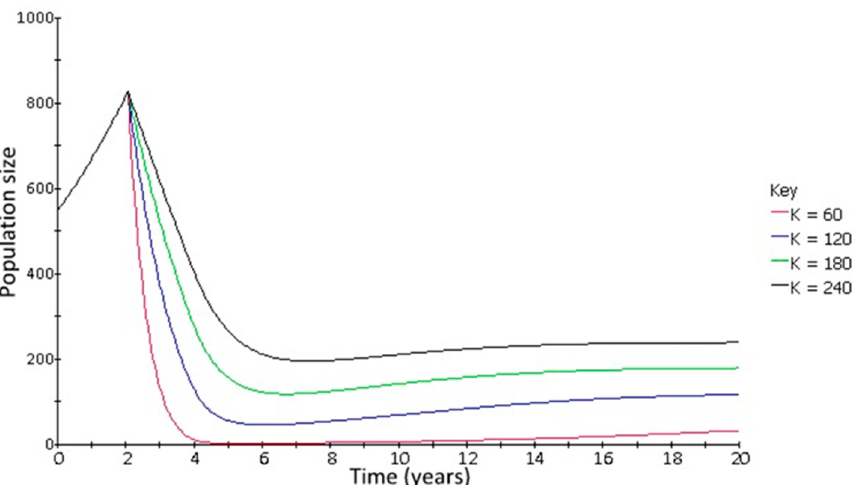
Figure 14. Four population growth trajectories under the density-dependent lagged logistic popu- lation growth model with a lag period τ = 2 years, intrinsic growth rate r = 0.2, initial population of 550 plants, and K = 60, 120, 180, and 240. Changes in carrying capacity cause sharp declines in the population within three years but do not cause total collapse except when K = 60 when the population declines to near zero.